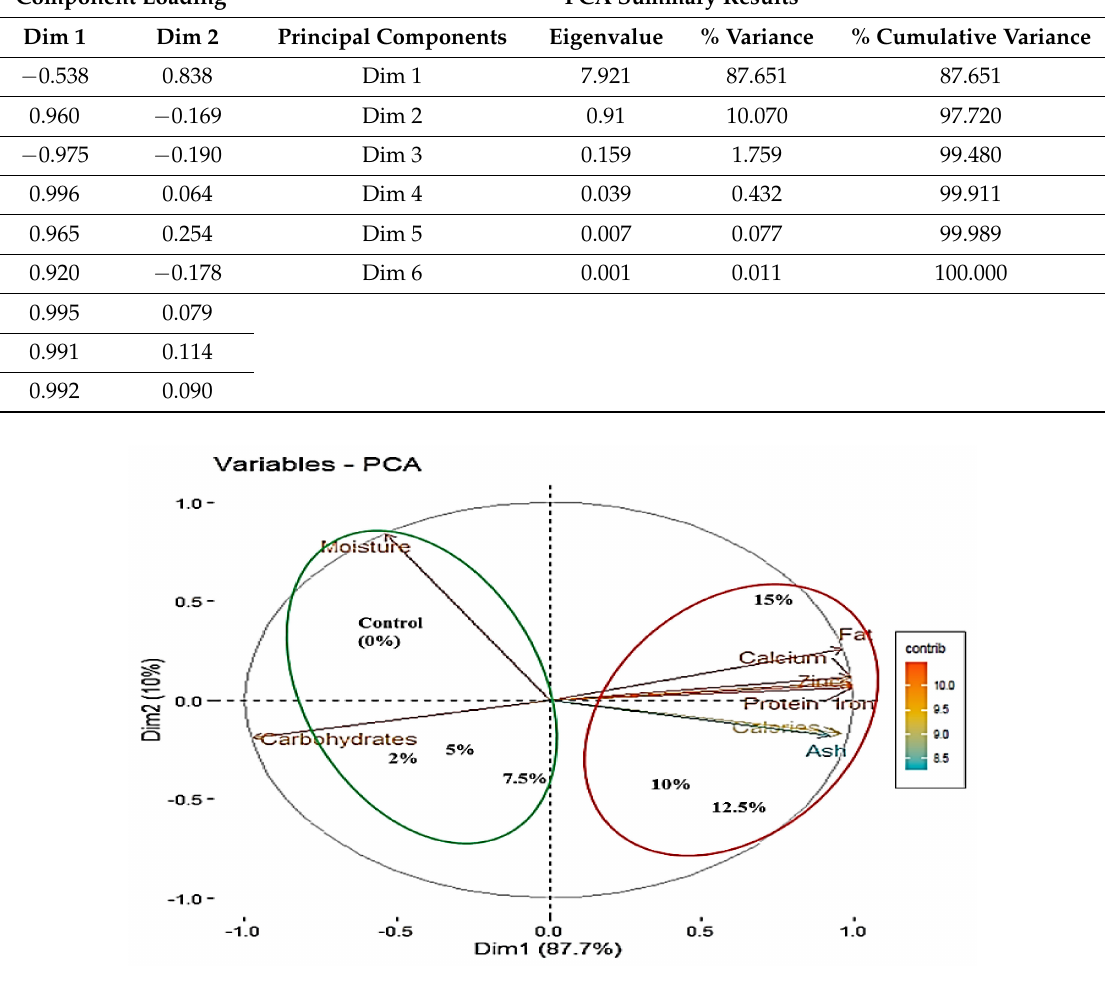
Figure 3. Results of PCA of data on the effect of supplementation of pasta with different concentra- tions of Spirulina biomass (%) on nutritional parameters presented as scatter